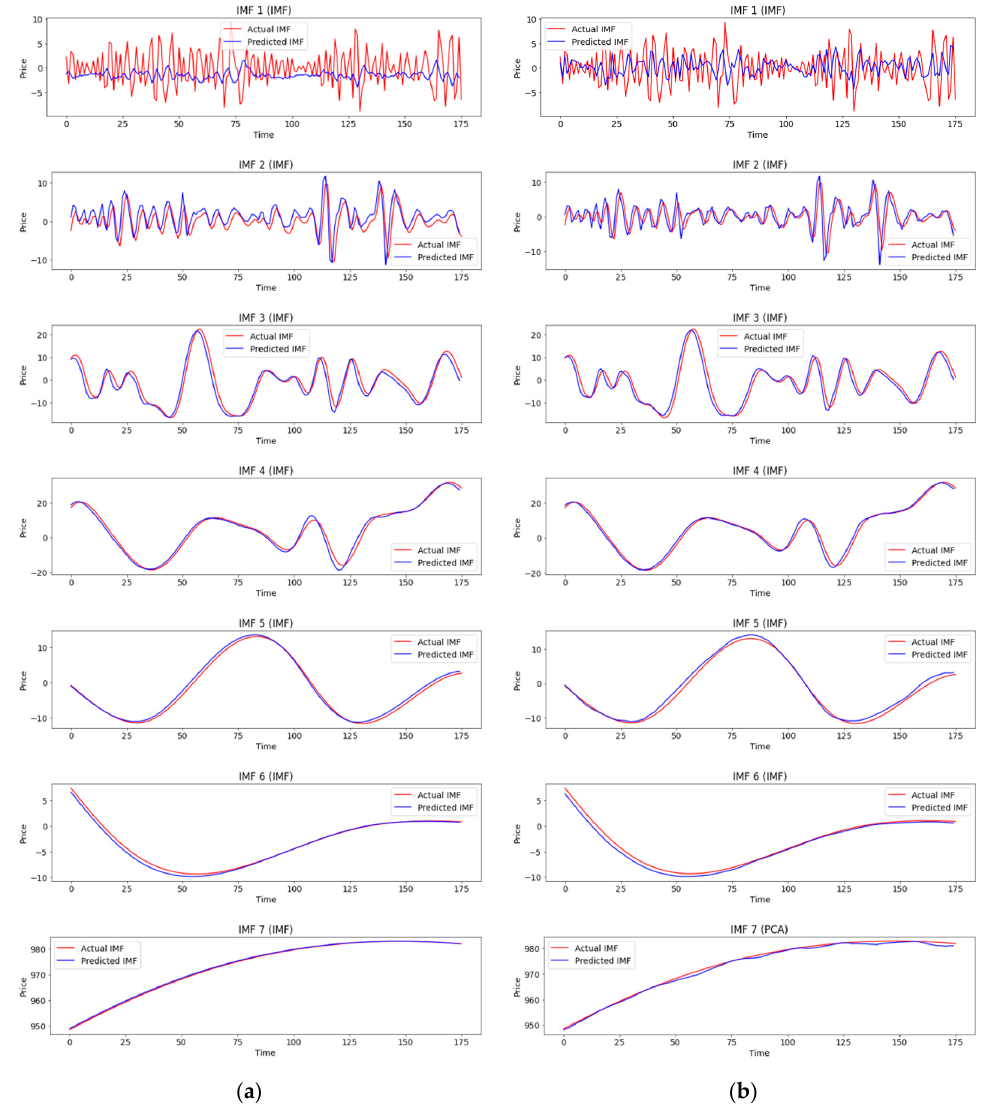
Figure 10. Results of IMF prediction using only IMF value ( a ) and principal component ( b